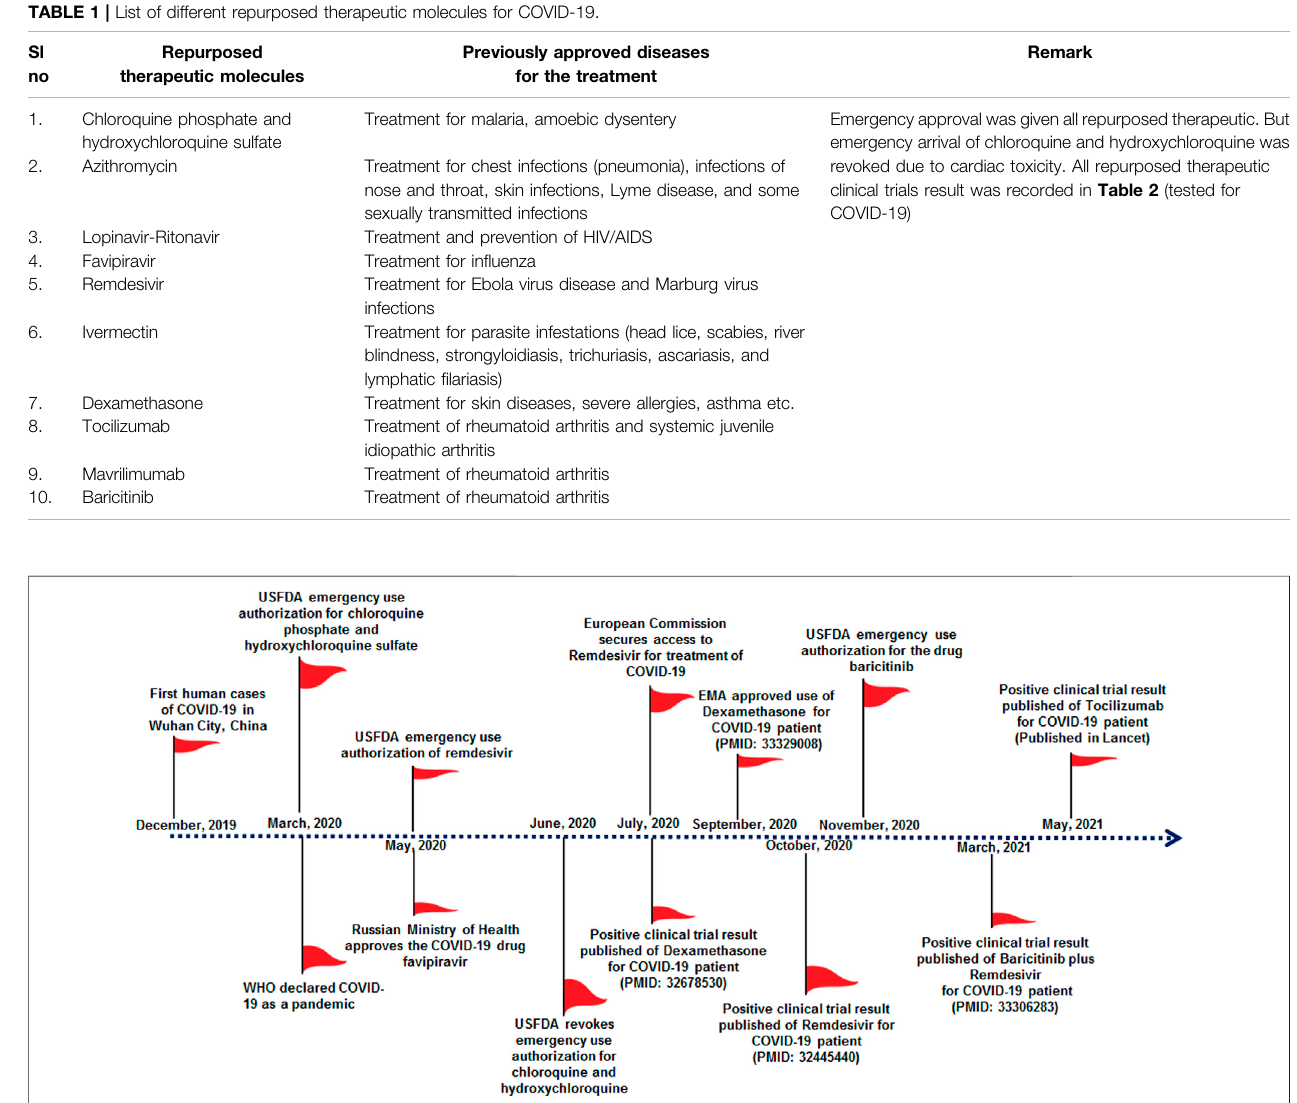
FIGURE 1 | Signi fi cant milestones of COVID-19 therapeutic development in the previous 1 year, which show emergency approval of therapeutic molecules by different countries regulatory authorities for the treatment of COVID-19. This approval initiated several clinical trials for therapeutic repurposing of the drug for COVID-19 treatment, and signi fi cant clinical trials are listed in Table 2 . Important milestones are listed in the timeline.